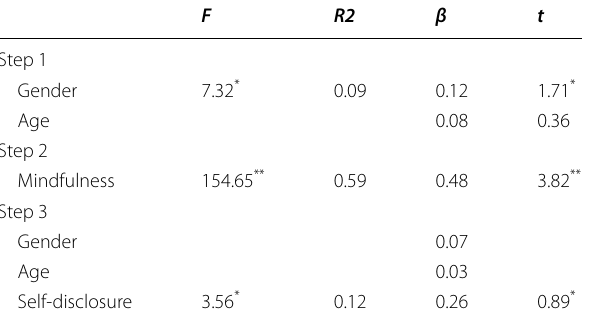
was added in the second step, 48% of the probability of predicting wellness was explained, which is also statisti- cally significant ( t 3.93, p < 0.001). In the third step, = self-disclosure was added to explain 15% of the total independent variables for well-being ( t 1.32, p < 0.01). = Table 5 Hierarchical regression analysis of happiness as Table 6 Hierarchical regression analysis of well-being as dependent variable ( N 486) and gender, age, mindfulness, and dependent variable ( N 486) and gender, age, mindfulness, = = self-disclosure